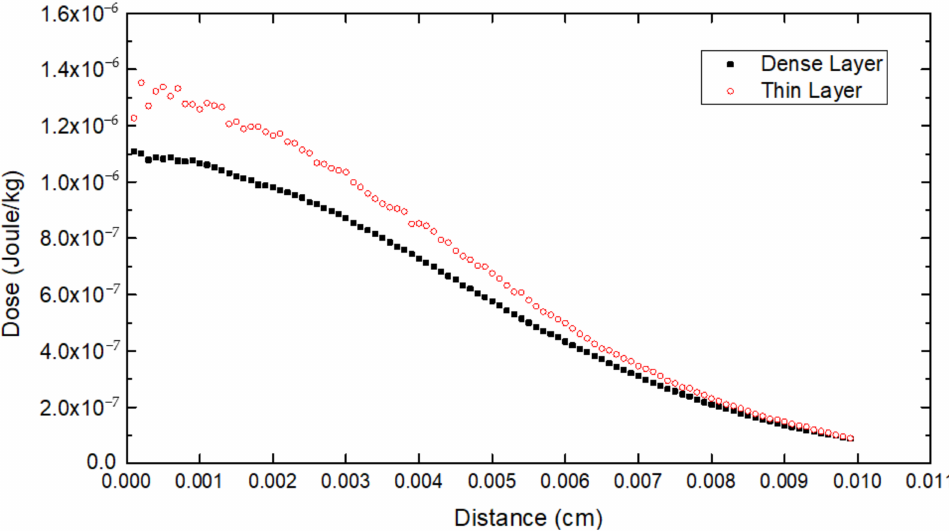
Figure 5. Results of MC simulations: absorbed dose at the metal layer for both thin and dense layers of He above the